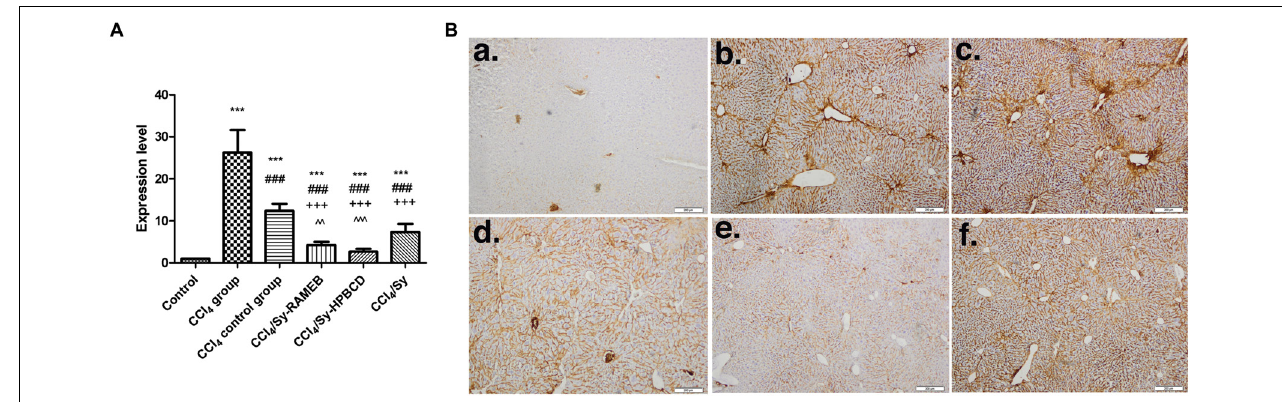
FIGURE 6 | The mRNA expression and specific tissue distribution of α -SMA. (A) RT-PCR analysis of α -SMA gene level. ∗∗∗ p < 0.001 compared to control; ### p < 0.001 compared to CCl 4 group; +++ p < 0.001 compared to CCl 4 control group; ˆˆ p < 0.01 compared to CCl 4 /Sy group; ˆˆˆ p < 0.001 compared with CCl 4 /Sy group. (B) Immunohistochemical expression of α -SMA in experimental livers. (a) Control group, (b) CCl 4 -treated group, (c) CCl 4 -control group, (d) CCl 4 and Sy-RAMEB co-treated group, (e) CCl 4 and Sy-HPBCD co-treated group, (f) CCl 4 and free Sy co-treated group.